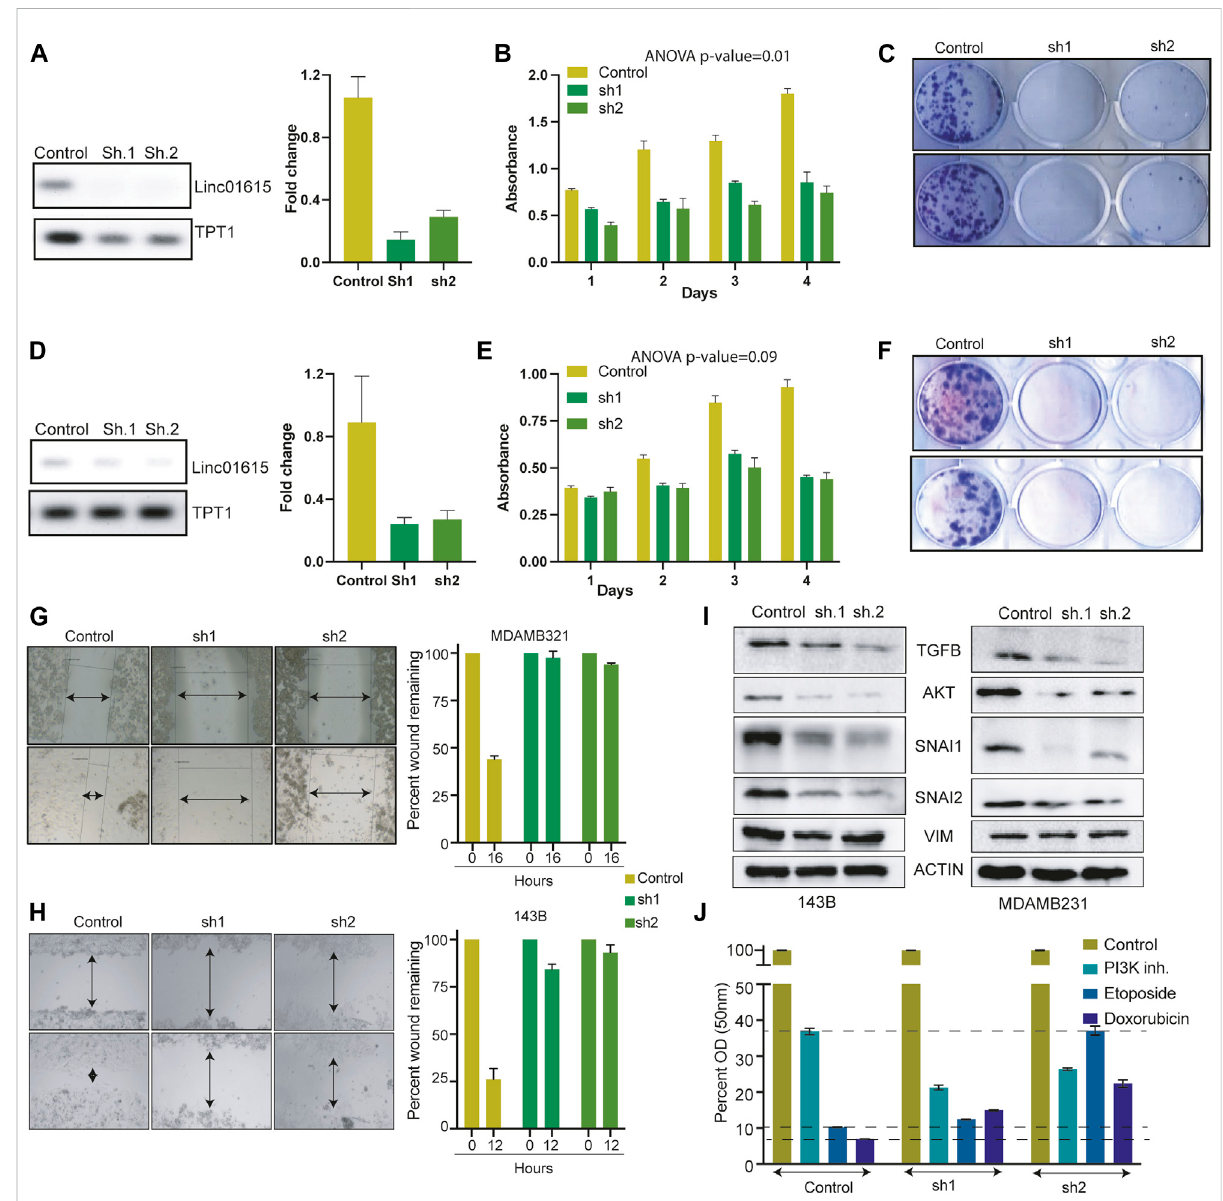
Linc01615 is required for cell proliferation and cell migration: (A) Semi-quantitative and Q-PCR data showing the decreased RNA level of Linc01615afterknockdowninMDAMB231cells.EffectofLinc01615knockdownonMDAMB231 (B) Cellproliferation (C) Colonyformationability. (D) Semi-quantitativeandQ-PCRdatashowingthedecreasedRNAlevelofLinc01615afterknockdownin143Bcells.EffectofLinc01615knockdownon MDAMB231 (E) Cell proliferation (F) Colony formation ability. The effect of Linc01615 knockdown on (G) MDAMB231 and (H) 143B cells cell migrationability. (I) Linc01615wasknocked down inMDAMB231 and143Bcells, and thelevel ofmentionedproteinwaschecked usingwestern blot. (J) 143B control and Linc01615 Sh1 and sh2 cells were treated with PI3K inhibitor, Etoposide and Doxorubicin in triplicate and MTT assay was performed after 48